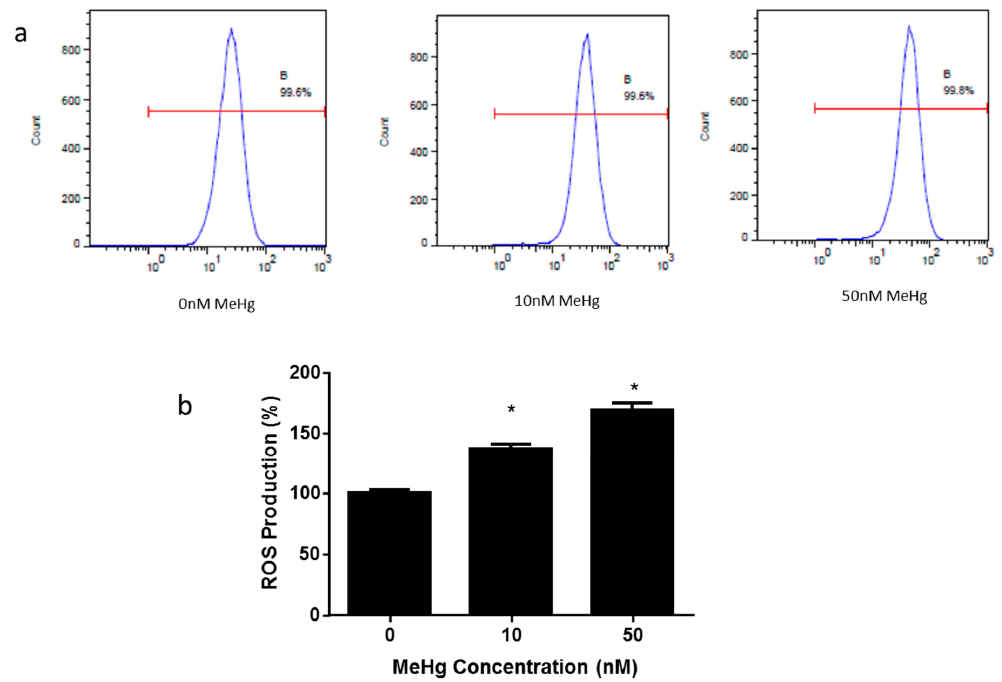
Figure 3. Effect of MeHg on the production of reactive oxygen species (ROS) in ihNPCs. Cells were treated with 0 nM, 10 nM, and 50 nM MeHg, and the level of ROS was analyzed. ( a ) ROS levels after MeHg treatment were analyzed by flow cytometry; ( b ) The relative ROS levels were presented as fold differences based on those at 0 nM. Results are expressed as mean ± SEM ( n = 3). * p < 0.05 when compared with the corresponding control group (0 nM MeHg).